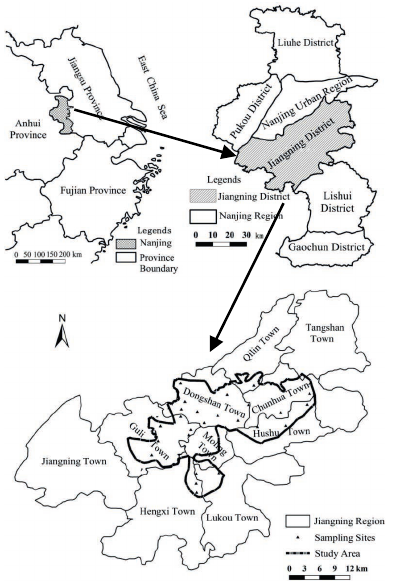
Fig. 1 Locations of the study area and the experiment